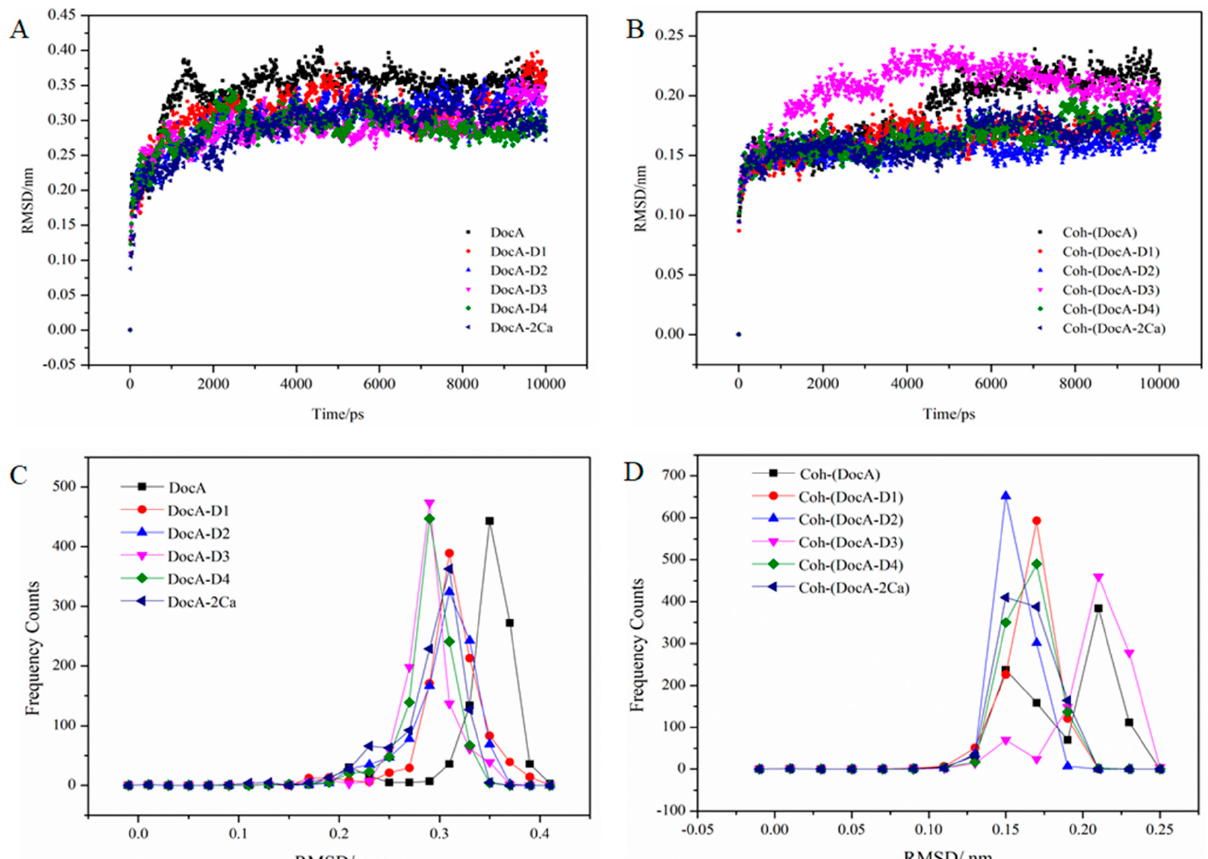
Figure 5. RMSD scatter plots of DocA mutants/Coh in molecular dynamics simulation. ( A ) Scatter plots of RMSD values of DocA mutants. ( B ) Scatter plots of the RMSD value of Coh interacting with the DocA mutants. ( C ) The total frequency chart of the RMSD value of the DocA mutants. ( D ) The total frequency chart of the RMSD value of Coh interacting with DocA mutants.